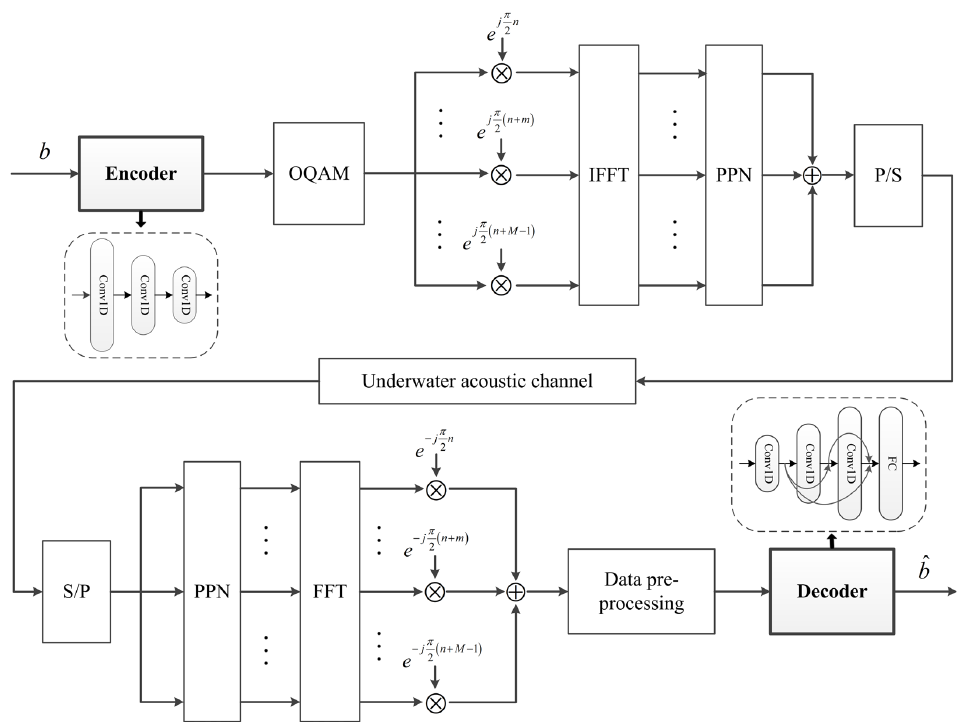
Figure 4. Block diagram of UWA FBMC system based on convolutional autoencoder network. Table 1. Parameter settings of autoencoder